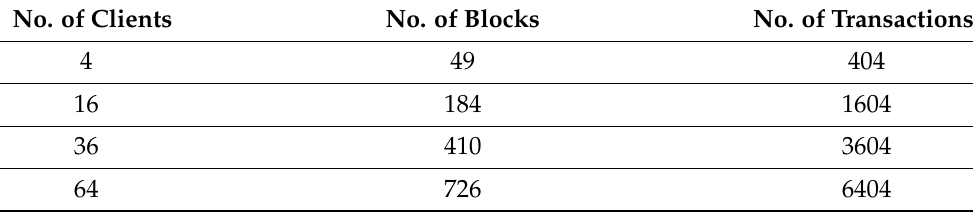
Table 5. Meter registration without the orchestration tool: multi-host-solo orderer.